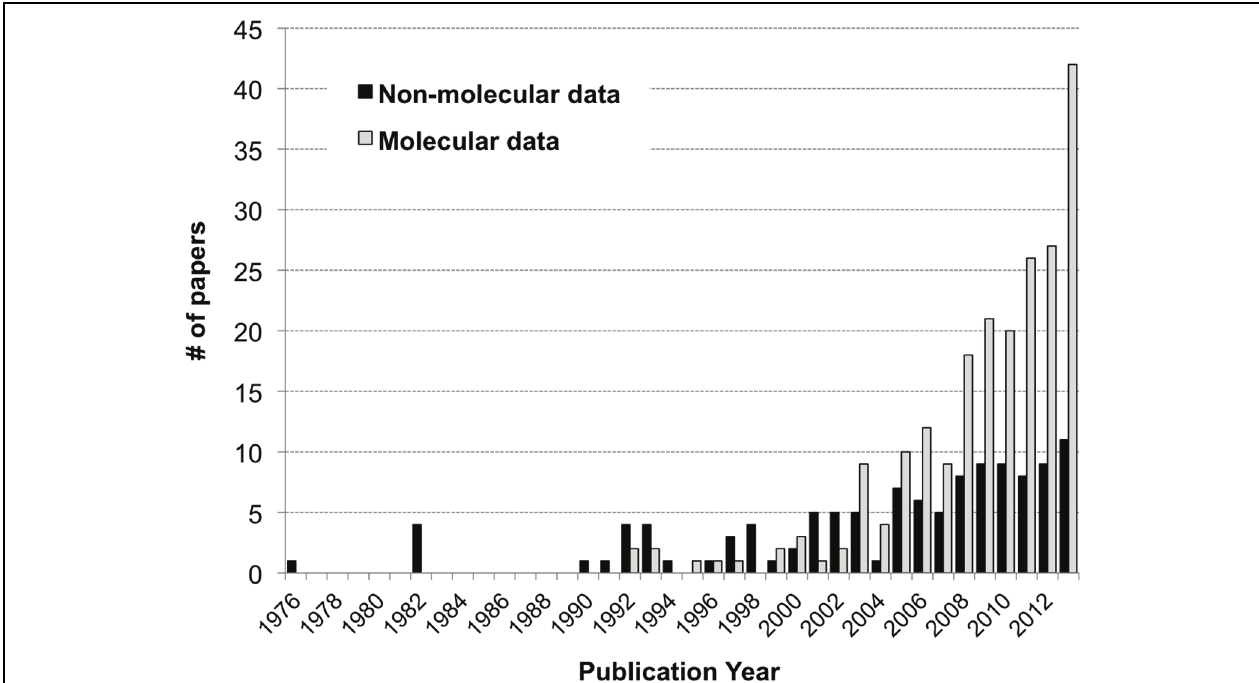
FIGURE 2 | Histogram of the number of papers reporting stream microbial diversity from 1992 to 2013: papers using molecular methods as gray bars, non-molecular methods as black